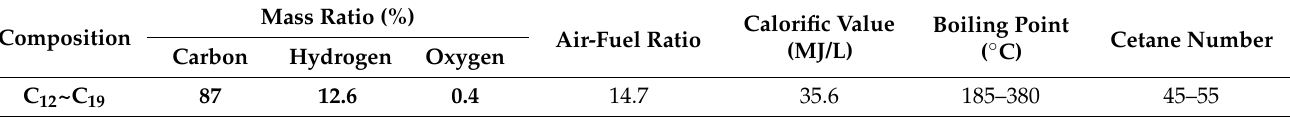
Table 2. Main technical characteristics of